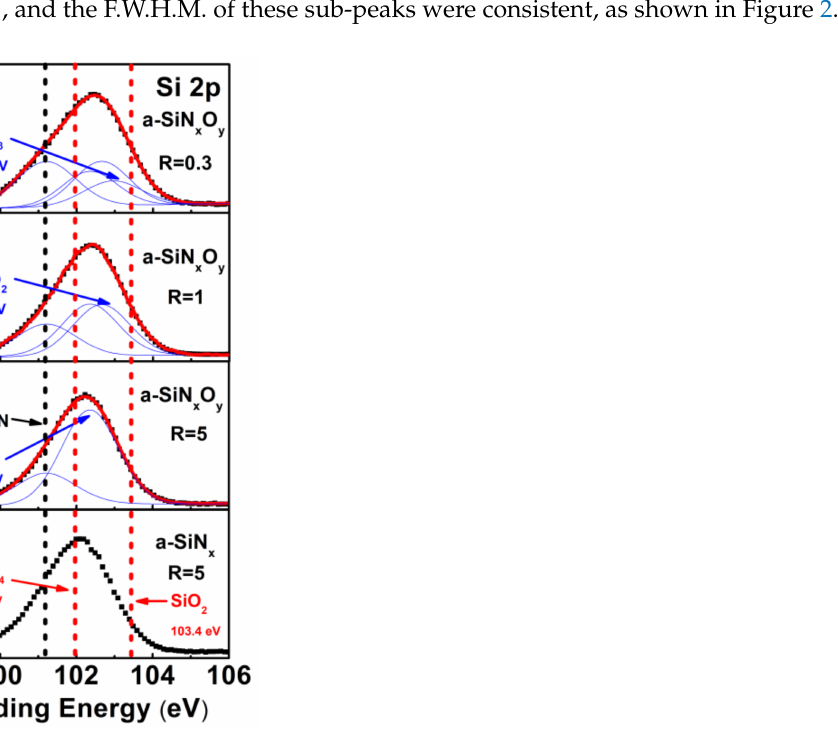
Figure 2. XPS spectra of Si 2p of both a-SiN x O y with ( a ) R = 0.3; ( b ) R = 1; ( c ) R = 5, and the controlled a-SiN x films with ( d ) R = 5, which was measured after Ar ion beam sputtering at 90 nm depth. For a-SiN x O y films with different R, the Voigt peak fitting results are also shown as a solid line. From the N 1s spectra in Figure 3, we can also observe similar rules. For a-SiN x O y films with different R, the binding energies of the N 1s peaks were located between the N 1s peak position of the standard proportion Si 3 N 4 (397.5 eV) and the N-Si 2 O bonding configuration (399.7 eV), respectively, in correspondence with the binding energies: three types of bonding configuration [15,16], namely N 3 -Si-O (397.9 eV), N 2 -Si-O 2 (398.5 eV), and N-Si-O 3 (399